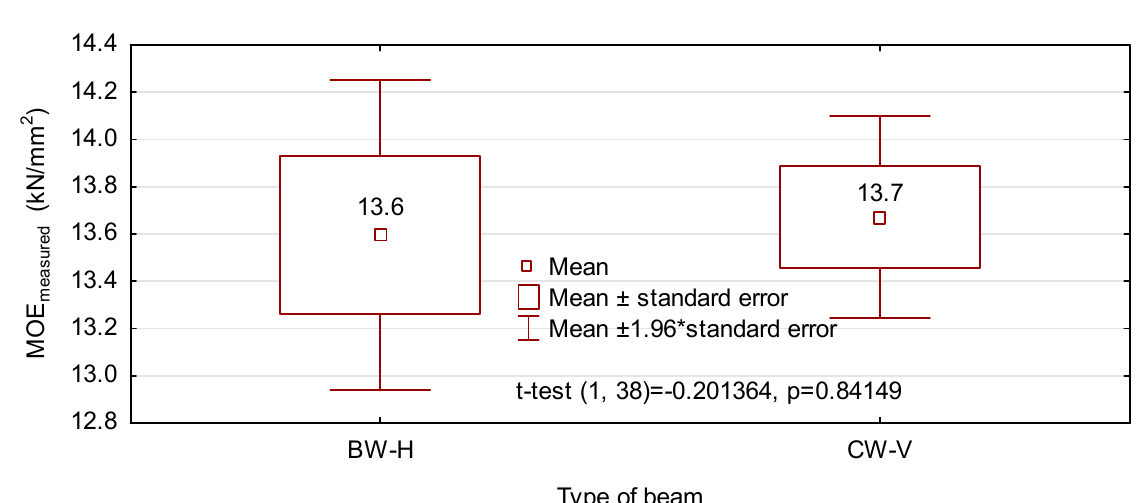
Figure 6. Histogram of the distribution of density.